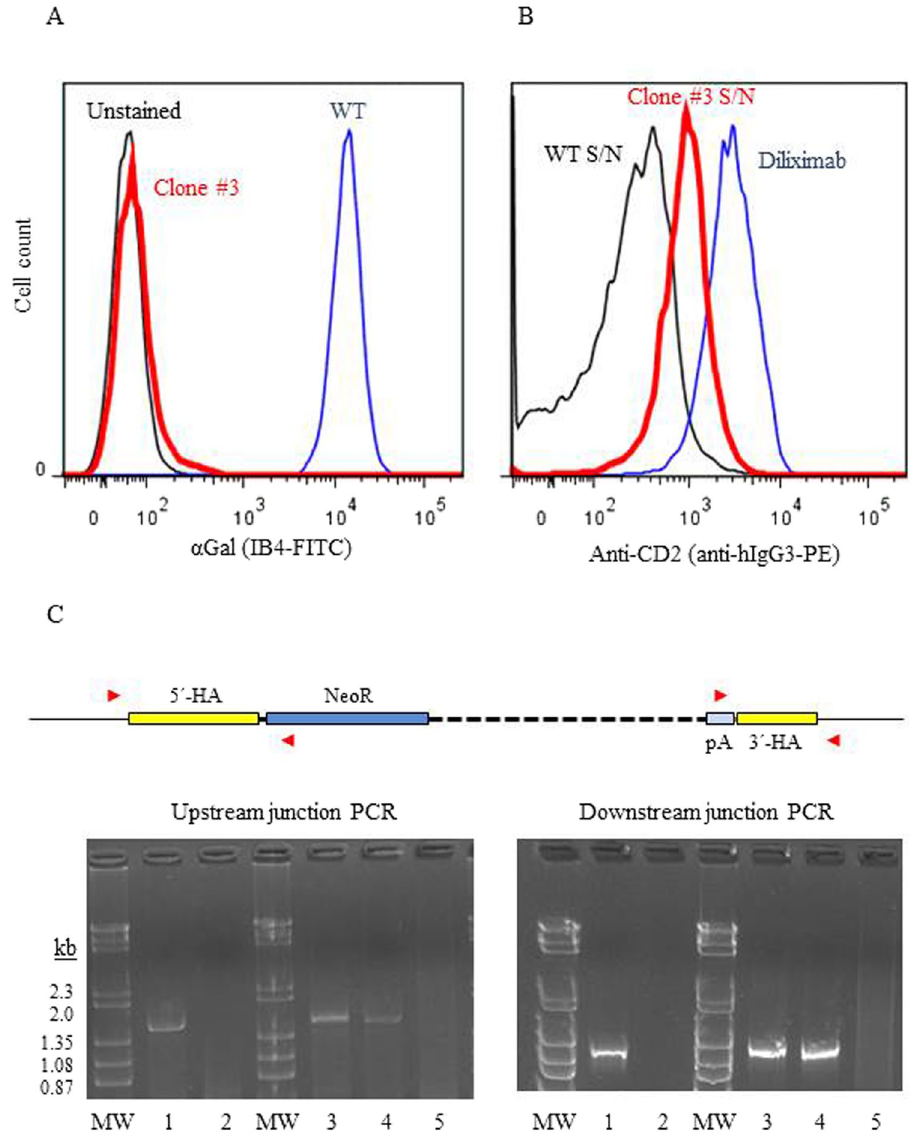
Figure 3. Analysis of pig fetal fibroblast anti-CD2 knock-in clone #3. ( A ) Absence of α Gal expression by clone #3 (red line); blue line, WT fibroblasts; black line, unstained WT fibroblasts. ( B ) Presence of anti-CD2 mAb diliximab in the supernatant of clone #3 (red line) detected as described in the legend to Fig. 2; blue line, positive control (20 ng/ml purified diliximab); black line, supernatant from WT fibroblasts. ( C ) PCR analysis to confirm correct targeting in clone #3 and in two piglets generated from clone #3 by somatic cell nuclear transfer. The schematic diagram (top) shows the expected genomic configuration for integration of the knock-in construct in GGTA1 ; the upstream and downstream homology arms (HA) are shown in yellow. Two primer pairs (red arrowheads; 5 ′ = UKI-F3/UKI-R2; 3 ′ = 117-F/1123-R), each with one primer outside and one primer within the targeting construct, were used with genomic DNA isolated from clone #3 fibroblasts (lanes 1), WT fibroblasts (lanes 2), two cloned piglets (lanes 3 and 4), and one WT piglet (lanes 5). Clone #3 and both cloned piglets generated upstream and downstream products of the expected size (1506 bp, lanes 1, 3 and 4, left hand gel; and 947 bp, lanes 1, 3 and 4, right hand gel, respectively), which were confirmed by sequencing. MW, molecular weight markers ( λ / Hin dIII + θ X174/ Hae